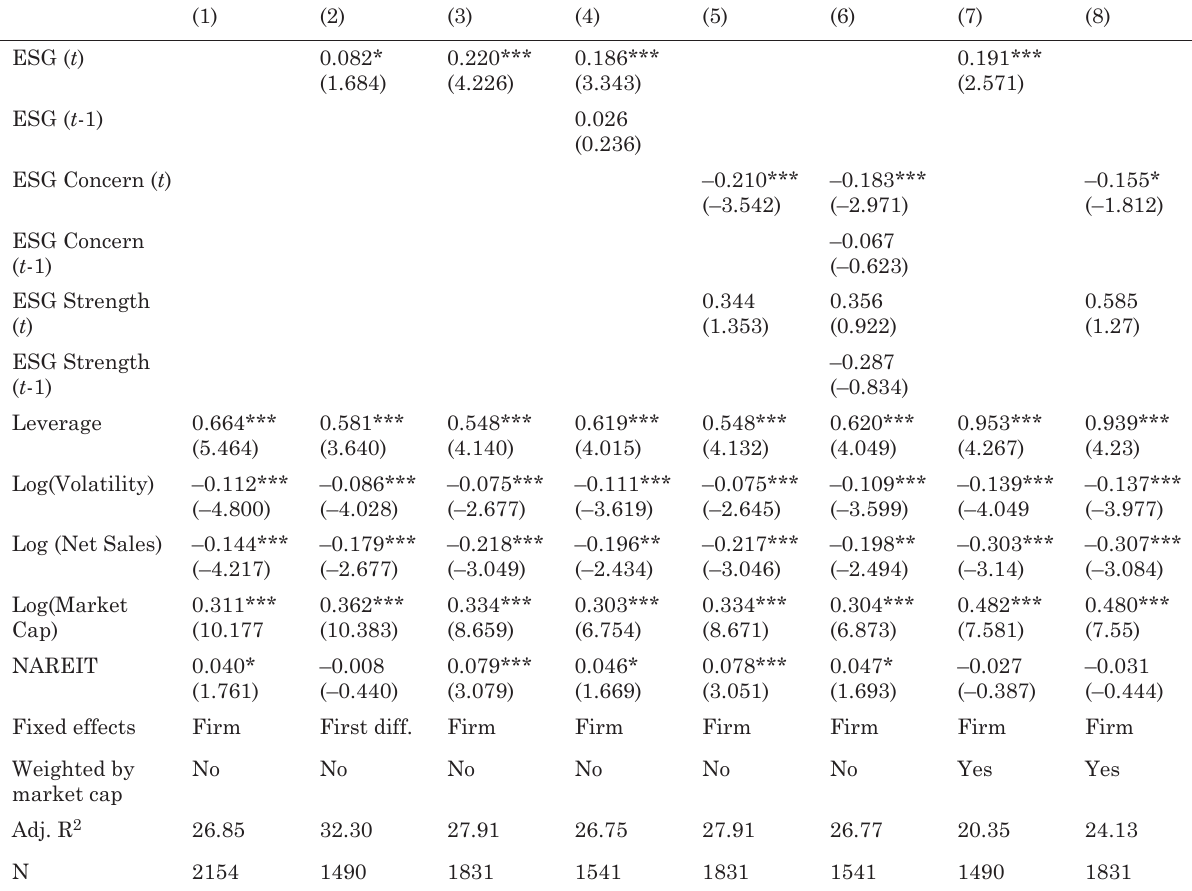
Table 5. Panel fixed effects regression results. Dependent variable: Log Tobin’s